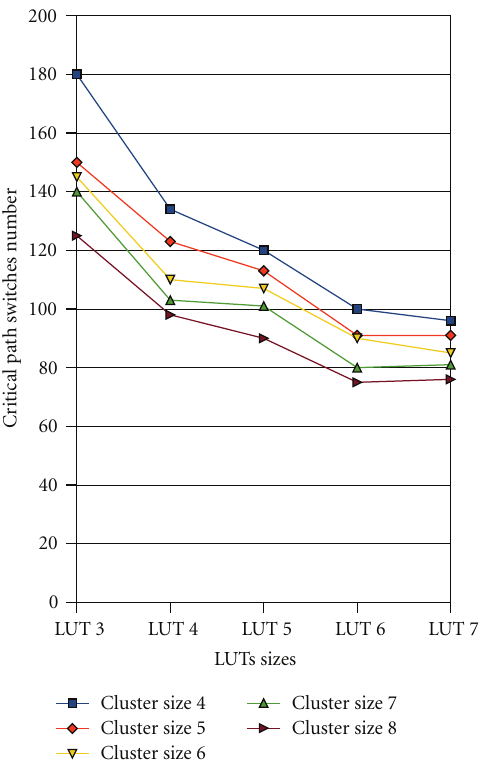
Figure 11: Bu ff ers number clusters sizes 4–8 (21 benchmark